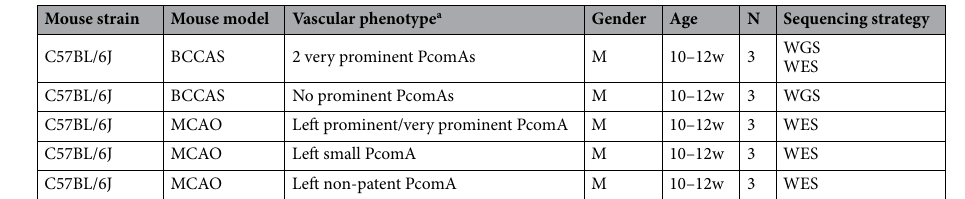
Table 2. Mouse exome/genome sequencing cohort. PcomA posterior communicating artery, ECA external carotid artery, M male, w weeks, WGS whole genome sequencing, WES whole exome sequencing. a The vascular phenotype classification has been already described (Foddis et al. 27